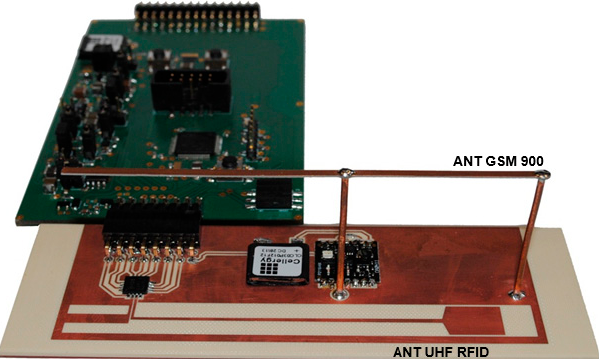
Figure 6. Practical implementation of autonomous RFID sensor operating in the UHF band. ANT GSM 900—antenna of harvester gathering energy from electromagnetic field generated by telecommunication system GSM 900, it is connected to Powercast P2110 module; ANT UHF RFID—antenna of RFID system operating in the UHF band, it is connected to AMS SL900A chip.